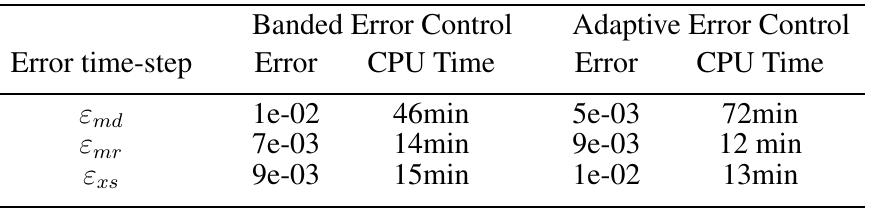
Figure 3: Evolution of local error in the Langenbuch transient with fixed time-step. Table 2: Errors and CPU time obtained with the adaptive time-step modal method.